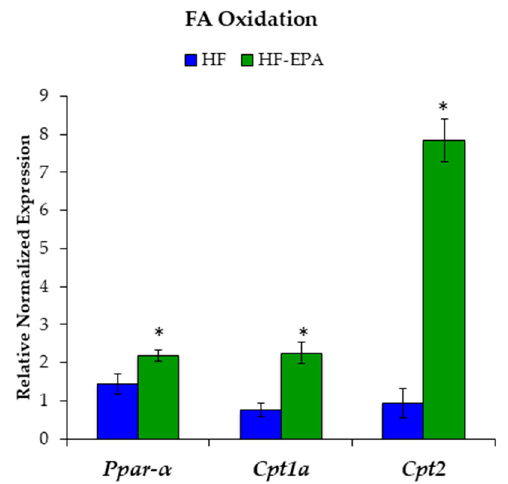
Figure 3. Eicosapentaenoic acid (EPA) supplementation increases hepatic fatty acid (FA) oxidation. Gene expression studies indicate significant increases in markers of FA